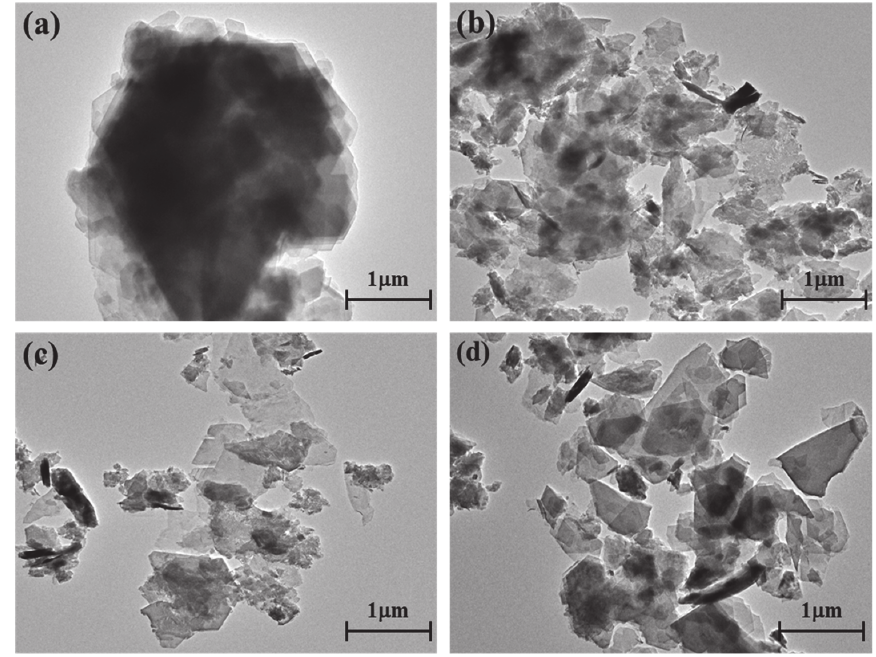
Figure 6. The TEM images of ( a ) original kaolinite; ( b ) the KAc–kaolinite complex; ( c ) the FA–kaolinite complex and ( d ) the DMSO–kaolinite complex.